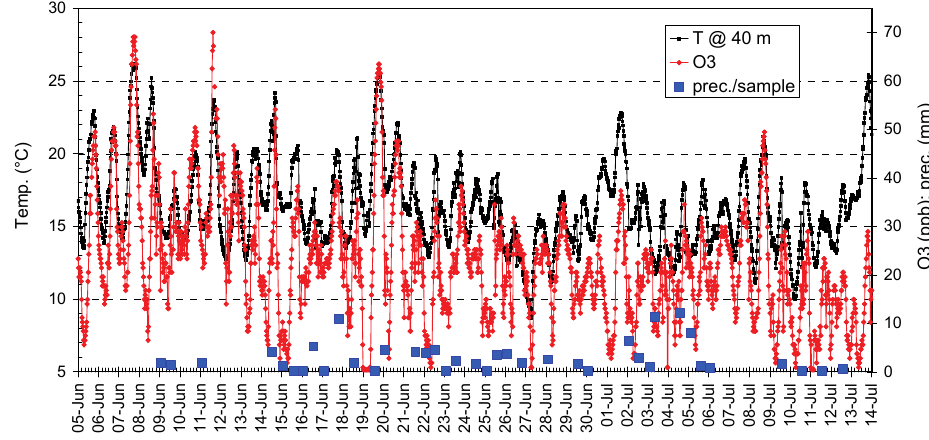
Figure 2. Time series for O and selected meteorological data during the 2007 summer Fig. 2. Time series for O 3 and selected meteorological data during the 2007 summer campaign in Brasschaat. 3 campaign in Brasschaat. size fraction front and back filters were analysed for water- soluble OC (WSOC) with a total organic carbon analyser, as described by Viana et al. (2006) and Chi (2009), and for water-soluble inorganic and organic species (i.e., MSA and LMW DCAs) by ion chromatography (IC), whereas the fine size fraction front filters were analysed for organosulfates, nitrooxy organosulfates, and terpenoic acids by liquid chro- matography with negative ion electrospray ionisation mass spectrometry